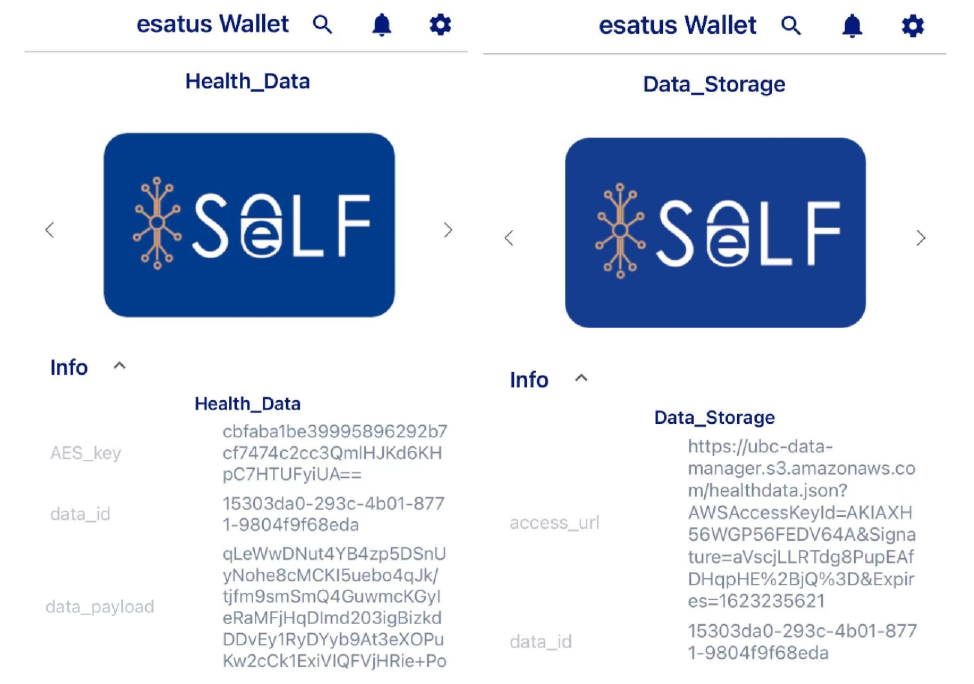
Fig. 9. The data credential and storage